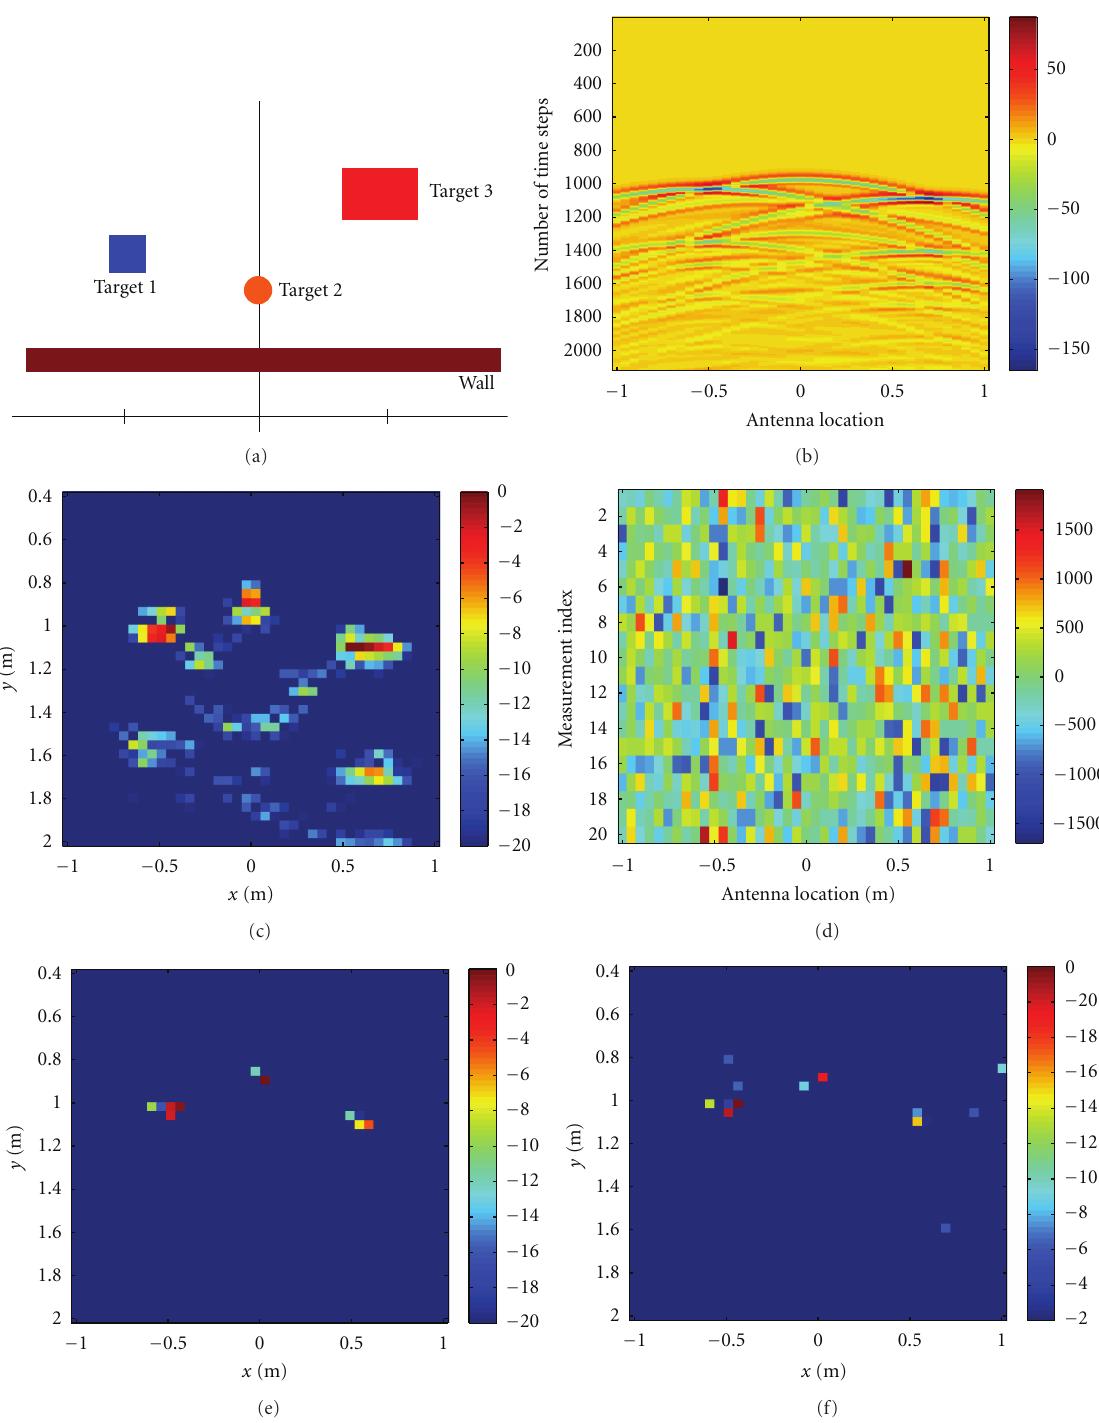
Figure 7: Imaging results of three PEC objects: (a) Target scene, (b) Conventional pulse radar measurement, (c) TDBP result, (d) CS measurement, (e) CS result, and (f) CS result under SNR = 0dB.